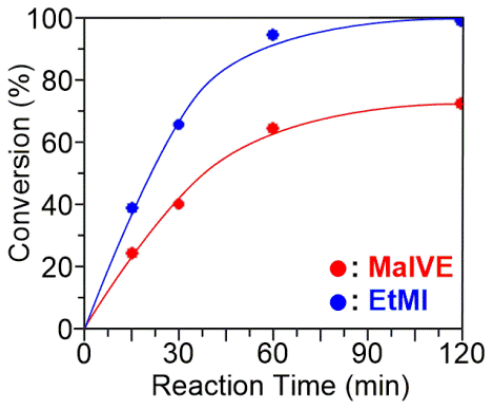
Figure 2. Time–monomer conversion curves for the RAFT copolymerization of MalVE and EtMI Figure 2. Time – monomer conversion curves for the RAFT copolymerization of MalVE and EtMI with with BTSE.